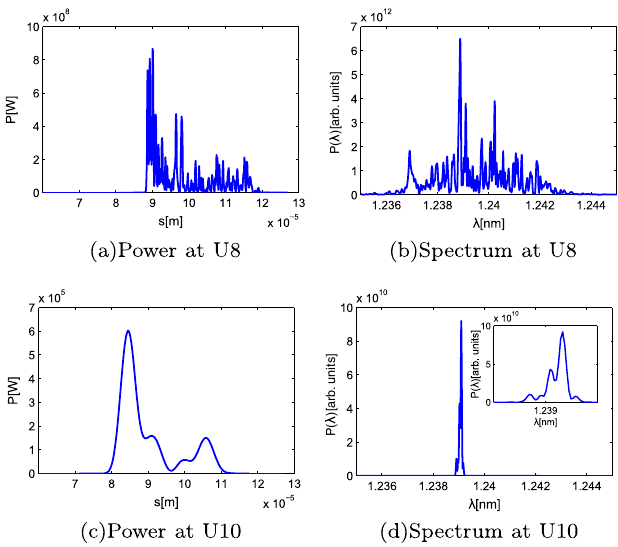
FIG. 12. 1000 eV FEL pulse at the end of the SASE undulator in time domain (a) was transformed to frequency domain (b). Spectrum was filtered (d) after being multiplied by the mono- chromator instrumental function (Fig. 15). Afterwards it was transformed back to time domain (c), representing effective power distribution at the entrance of the seeded undulator. while other frequencies are effectively blocked). After applying an inverse temporal Fourier transform, one obtains the FEL radiation in the time domain that can be used as a seed for the next undulator section in GENESIS simulations.